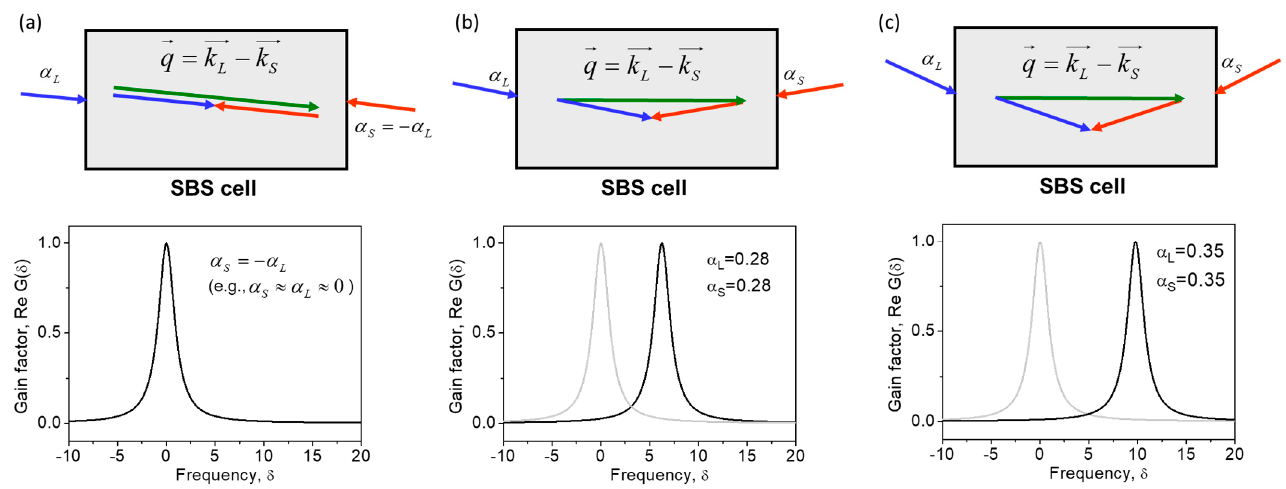
. This feature is illustrated in Figure 3.